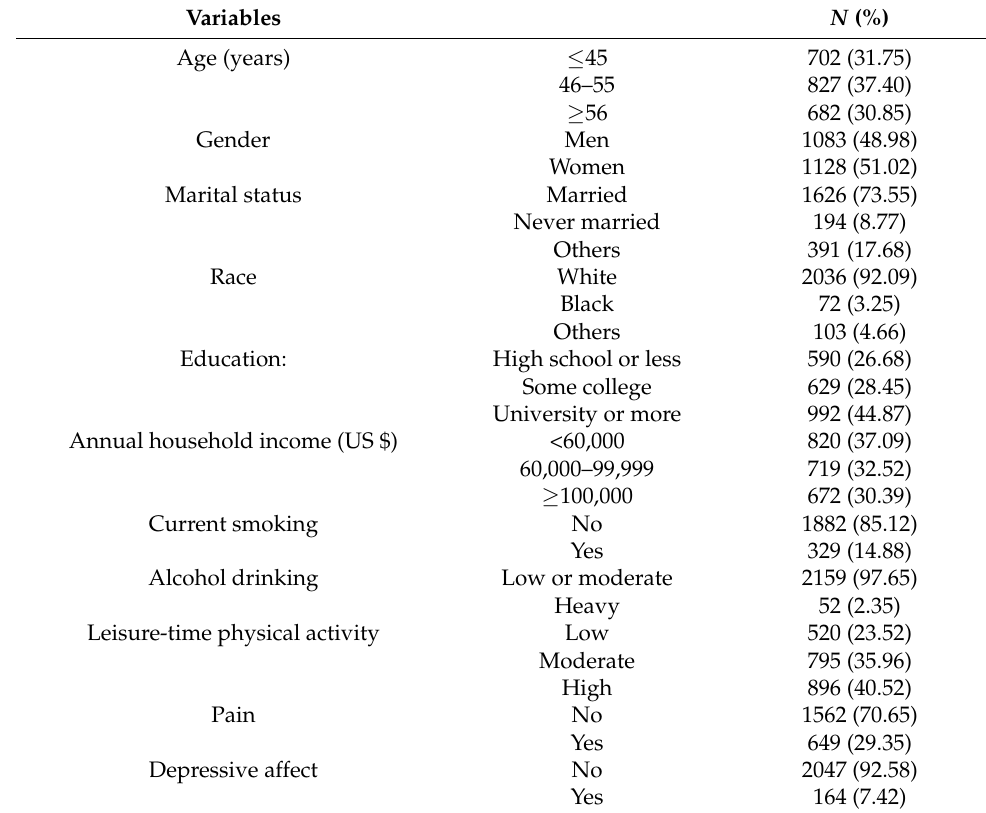
Table 1. Characteristics of the study sample ( N =